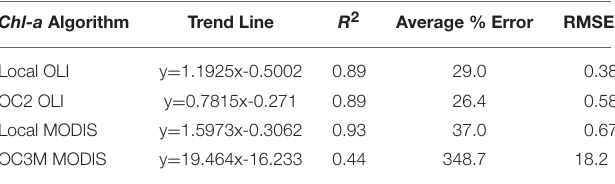
TABLE 3 | Comparison of local and standard OLI and MODIS algorithm chl-a retrievals vs. in situ chl-a on 11 November 2015 for nine observations (see Figure 6 for observation locations).